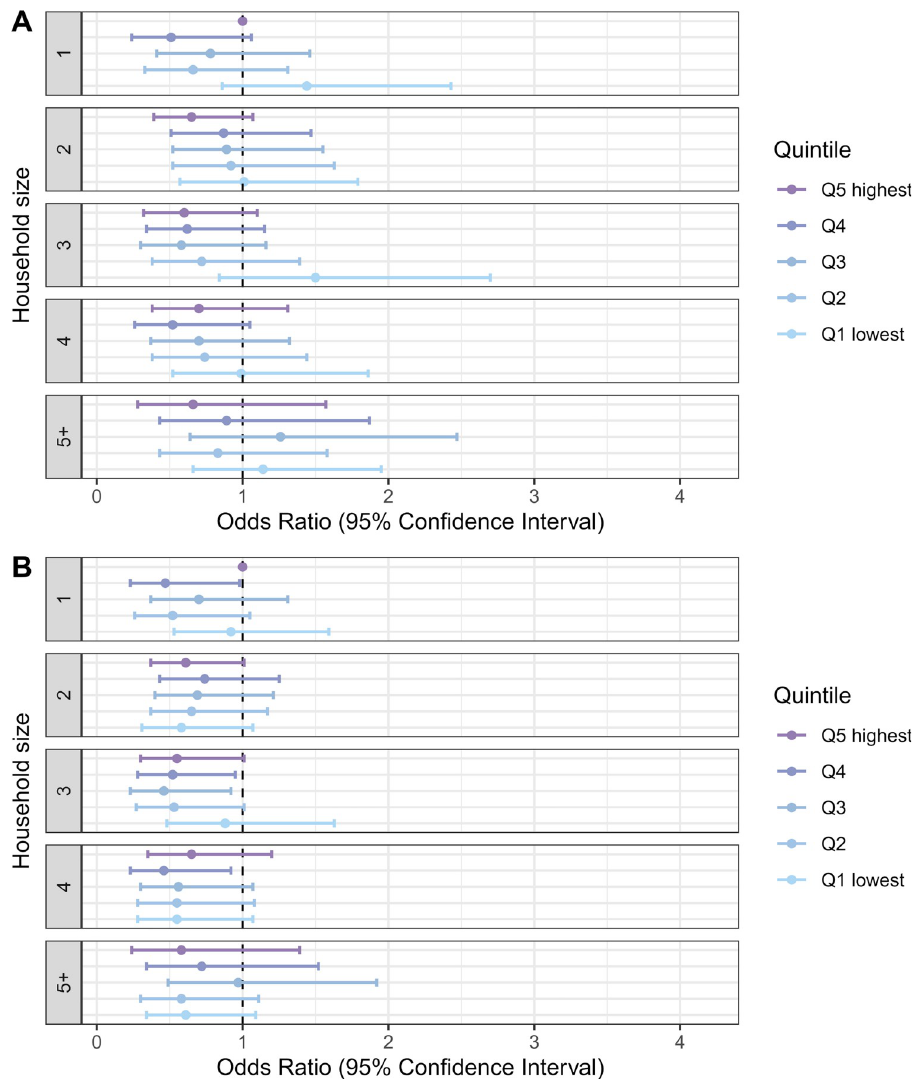
Fig 7. Odds ratios of severe COVID-19 illness among those infected by household income quintile and household size. In under-65 households ( A) adjusted for age and age squared, sex, regional characteristics, and comorbidities; (B) adjusted for age and age squared, sex, regional characteristics, comorbidities, household-level work and school exposures, and foreign background.